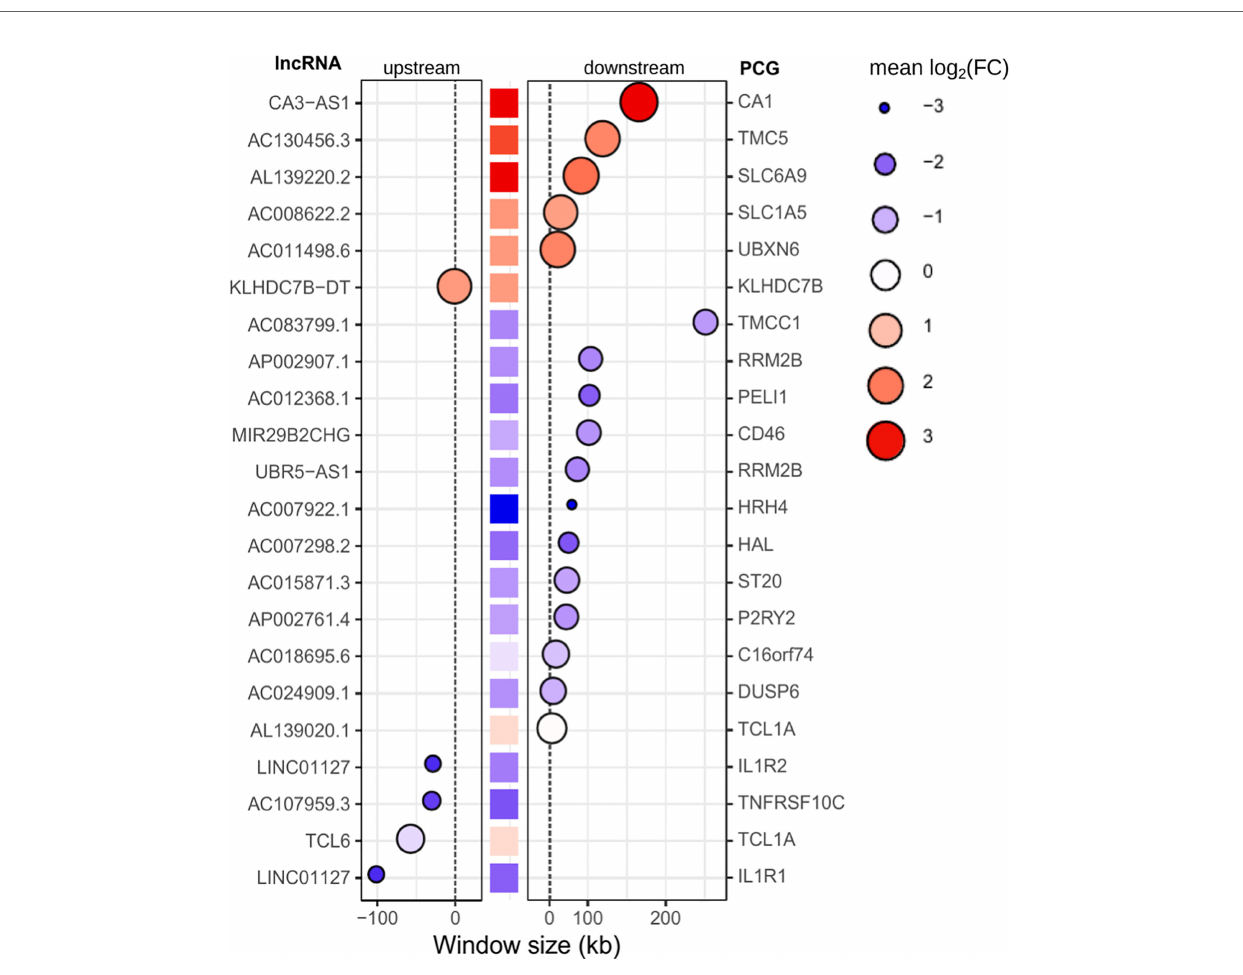
FIGURE 8 | Potential cis-acting lncRNAs inferred from highly correlated lncRNA-mRNA pairs in the genomic vicinity. A window size of 300 kb was set to consider cis -regulation. Gene IDs on the left refer to lncRNAs, whereas gene IDs on the right refer to PCGs (mRNAs). The central column of squares indicates the position of PCGs related to lncRNAs, and the graded color indicates the pattern regulation in PD0 (logFC). Bubbles indicate the position of lncRNAs upstream (left panel) or downstream (right panel) of the PCG. The size and color intensity of bubbles indicate the pattern regulation of lncRNAs in PD0. The blue scale indicates downregulation, whereas the red scale indicates upregulation in VL patients